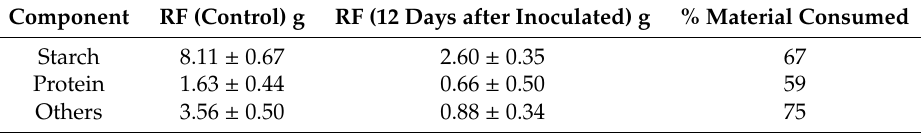
Table 2. Consumption analysis of the main components of ramon flour during CBP.